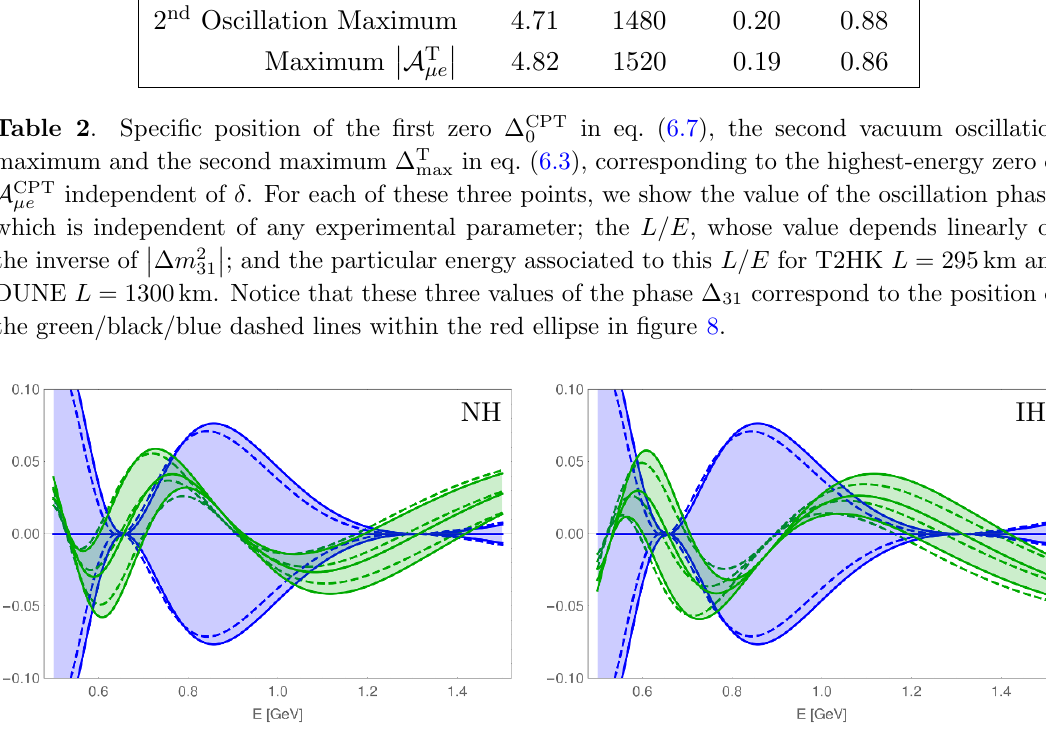
(green) and A T (blue) at DUNE L = 1300 (cid:22)e (cid:22)e